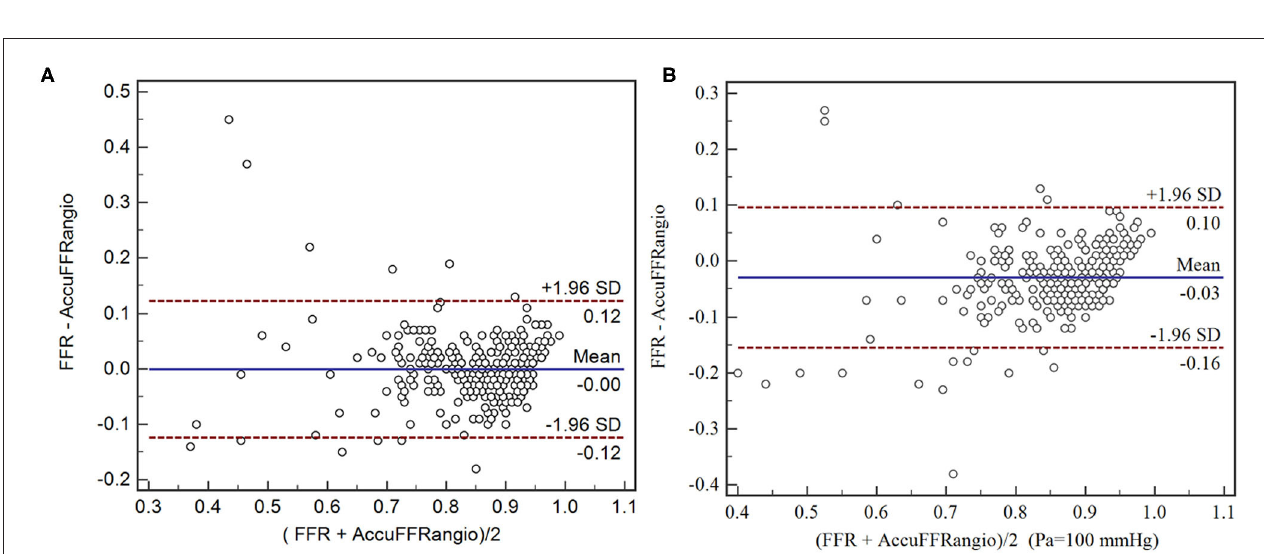
FIGURE 4 | Correlation between AccuFFRangio computation and conventional pressure wired measured FFR. (A) Pa from the measurement of the pressure at the coronary ostium; (B) Pa set as equal to 100 mmHg.